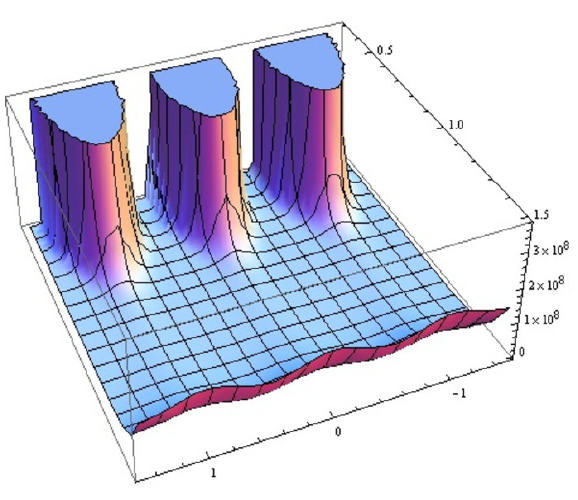
Figure 1 . The j -function close to the boundary (Im (cid:28) ) = 0 in a region of the upper halfplane H centered around (Re (cid:28) ) =